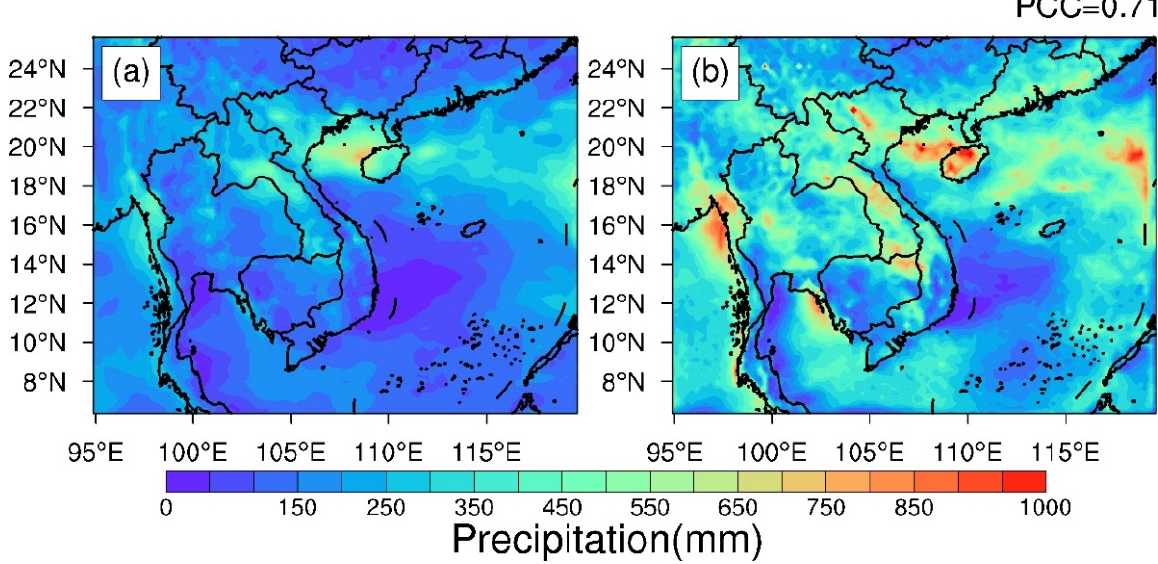
Figure 2. Distribution of total precipitation from 17 August 2016 to 6 September 2016. ( a ) ERA5, and ( b ) WRF simulations. Remote Sens. 2021 , 13 , x FOR PEER REVIEW